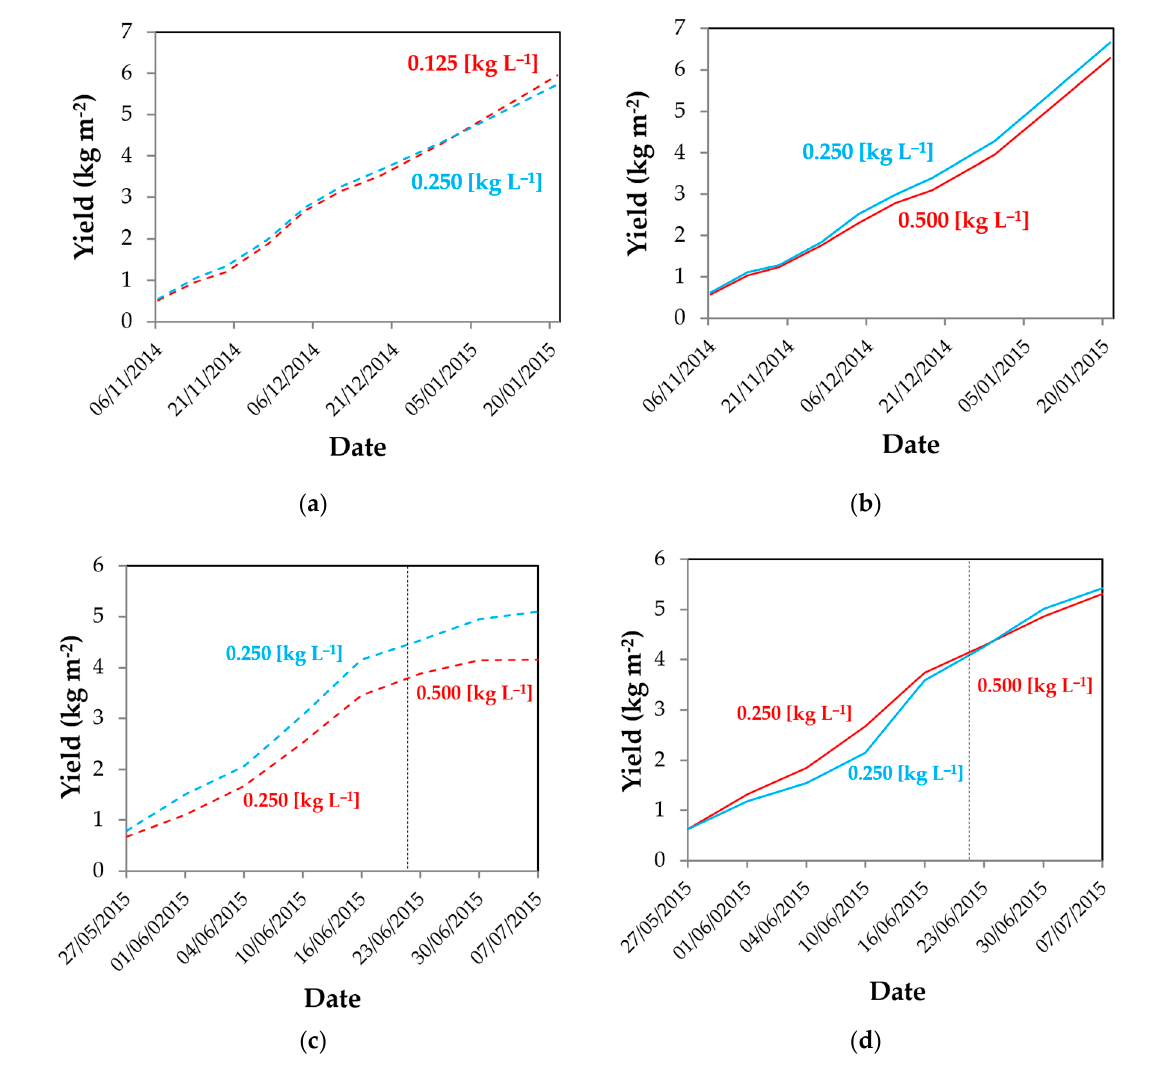
Figure 7. Evolution of tomato marketable production in the autumn–winter crop cycle ( a , b ) and the spring–summer crop cycle ( c , d ). East sector in greenhouses 1 (- - -) and 2 (––) with different concentrations and west sector with the control concentration of 0.250 kg L − 1 in both crop cycles in greenhouses 1 (- - -) and 2 ( ― ). Date of the change of concentration in the variable treatment (·····).